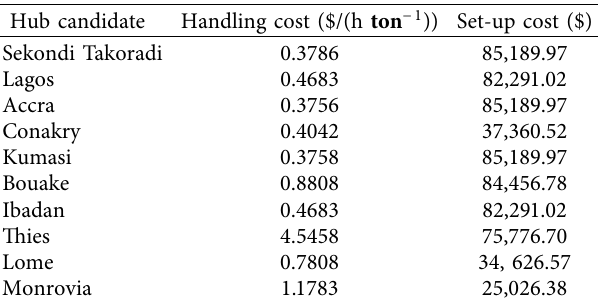
Table 5: Handling cost and set up cost by World Bank